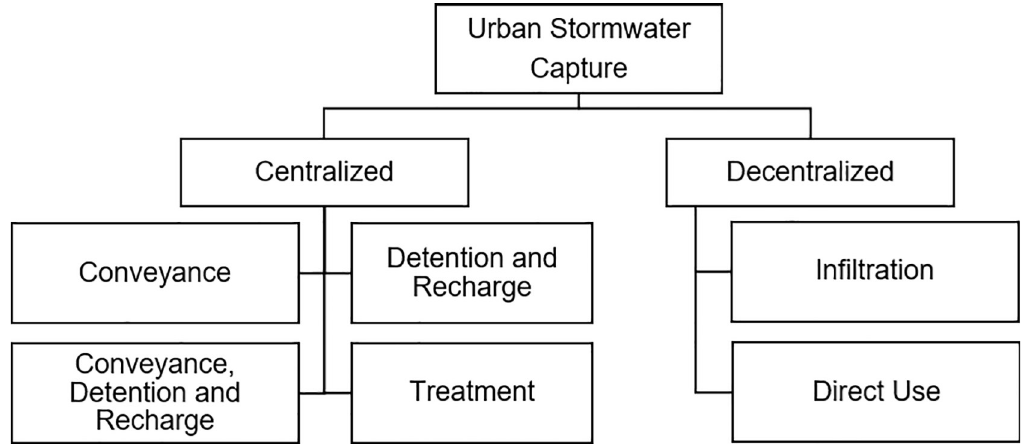
Fig 1. Stormwater typology for selected projects with the total number of projects included in the analysis for each project type.